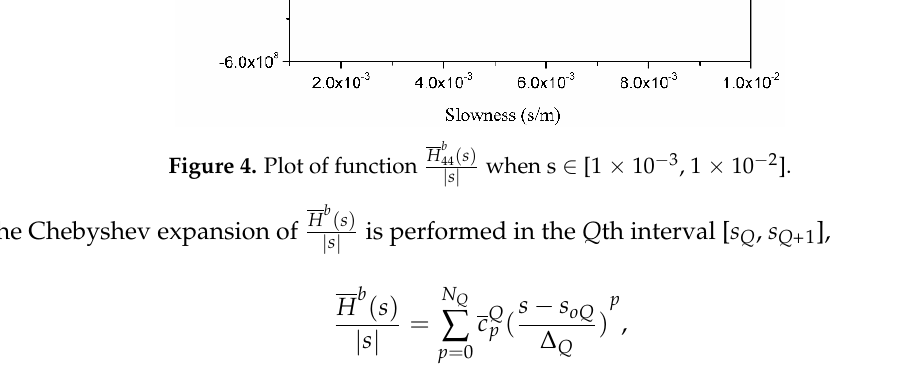
b ( s ) 44 when s ∈ [1 × 10 − 3 , 1 × 10 − 2 ( ) b H s | s | 44 s